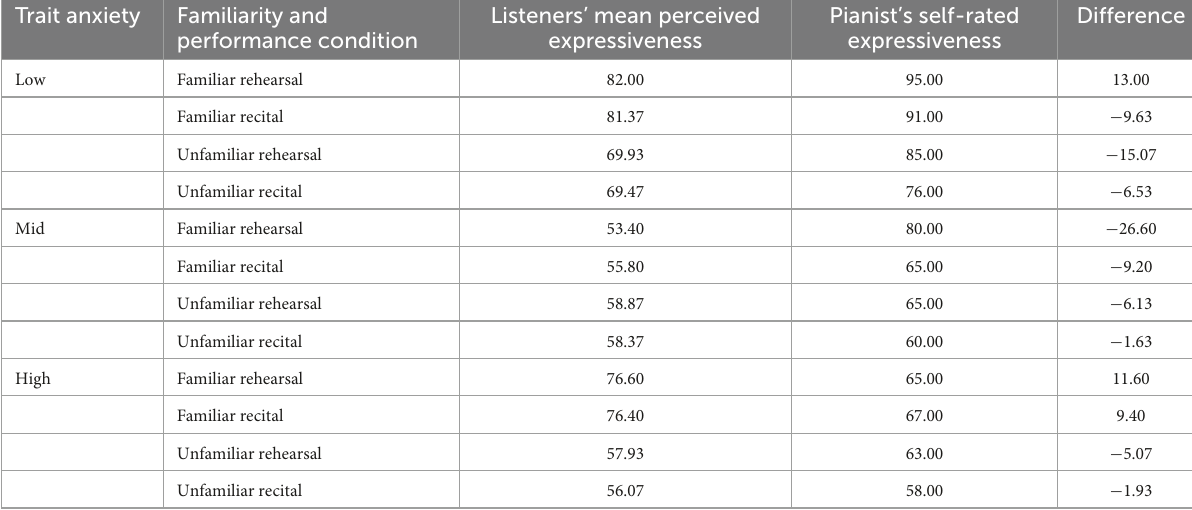
TABLE 4 Listeners’ mean perceived expressiveness and pianists’ self-reported